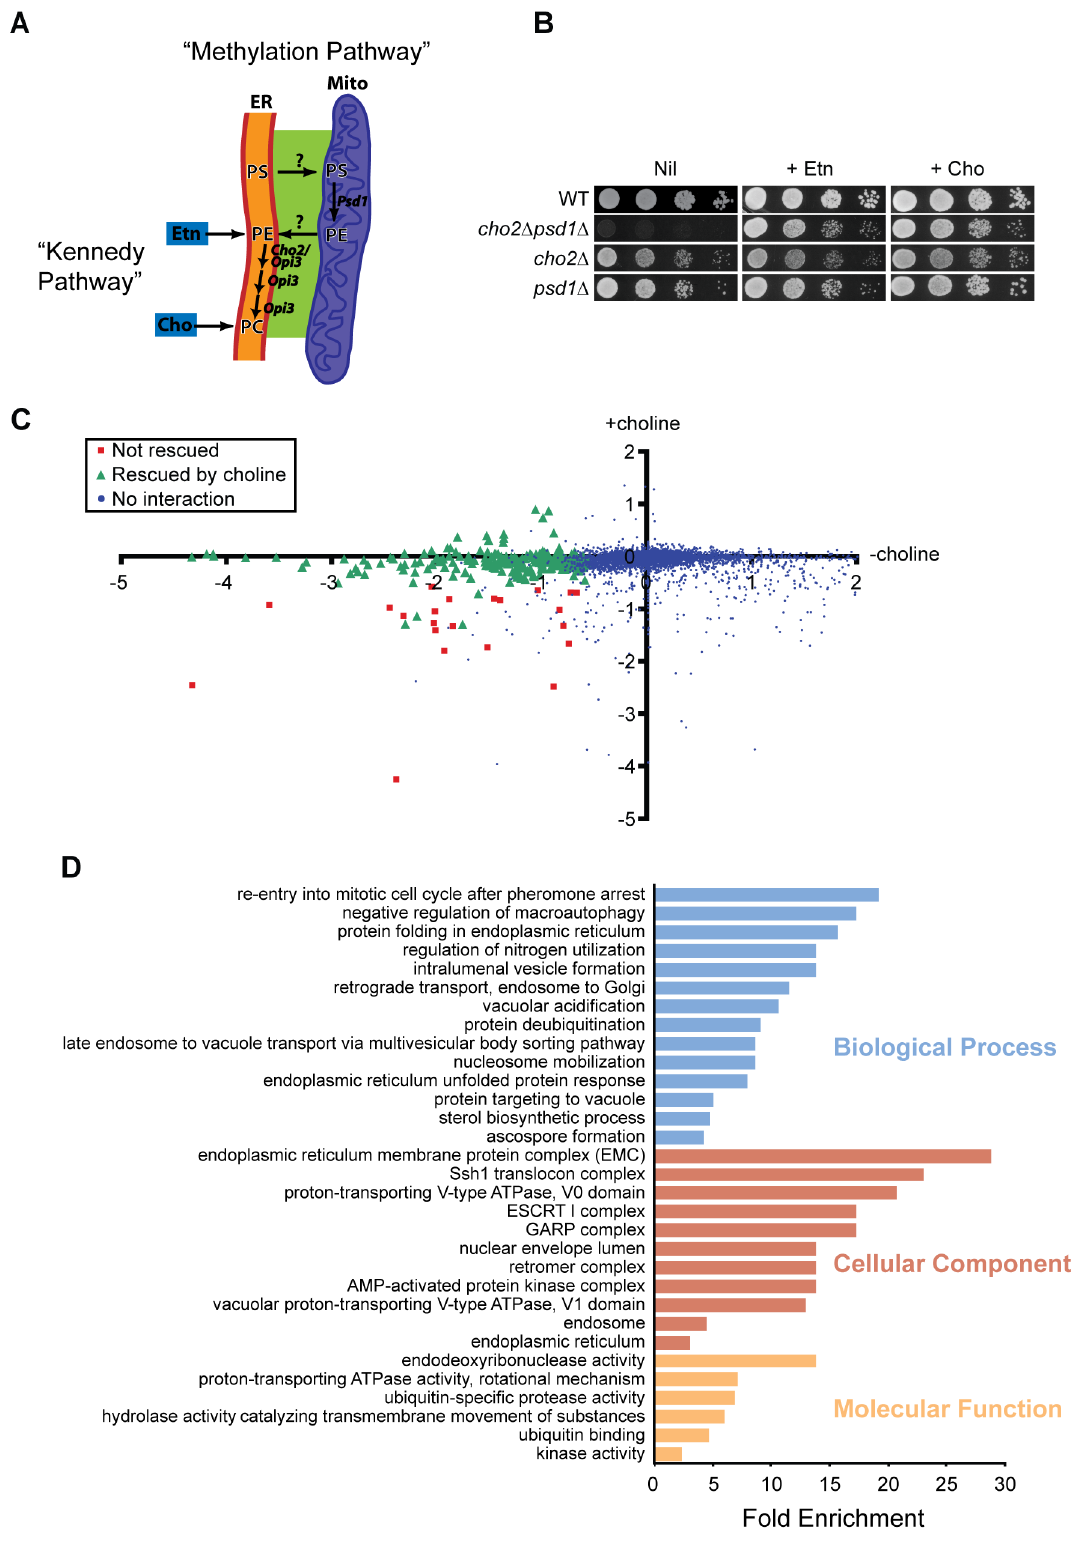
Figure 1. Genome-wide screen for regulators of phospholipid synthesis. (A) Phospholipid synthesis in the methylation pathway is compartmentalized between ER and mitochondria. PS synthesized in the ER is transferred to mitochondria for conversion into PE and transported back to the ER for conversion to PC. The Kennedy pathway synthesizes PE and PC from ethanolamine (etn) and choline (cho) independent of lipid transfer between ER and mitochondria. (B) Yeast growth assays for the indicated mutants in the absence (nil) or presence of ethanolamine ( + etn) or choline ( + cho). (C) Results of SGA screen for CHO2 in the absence (–) and presence ( + ) of choline. Genetic interactions are plotted as the log2 of the